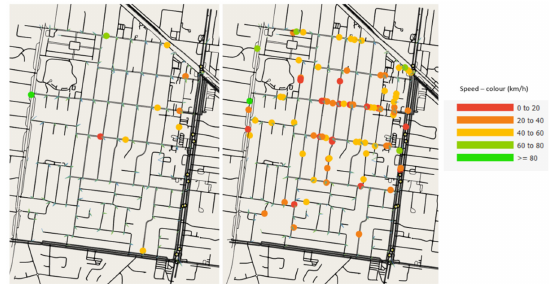
Figure 10. Cars and bicycles in the road network with current traffic demand ( left ) and stressed demand during a simulation ( right